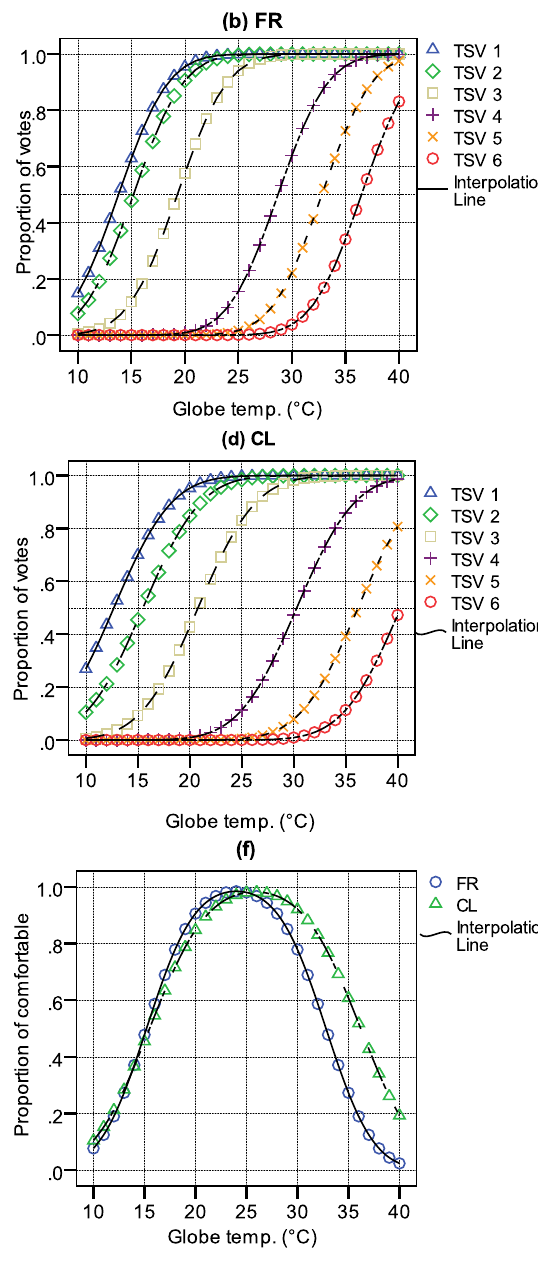
Figure 4. Proportion of thermal sensation vote (TSV) or comfortable (TSV 3, 4 or 5) for temperatures: ( a ) and ( b ) FR mode; ( c ) and ( d ) CL mode; ( e ) and ( f ) FR and CL